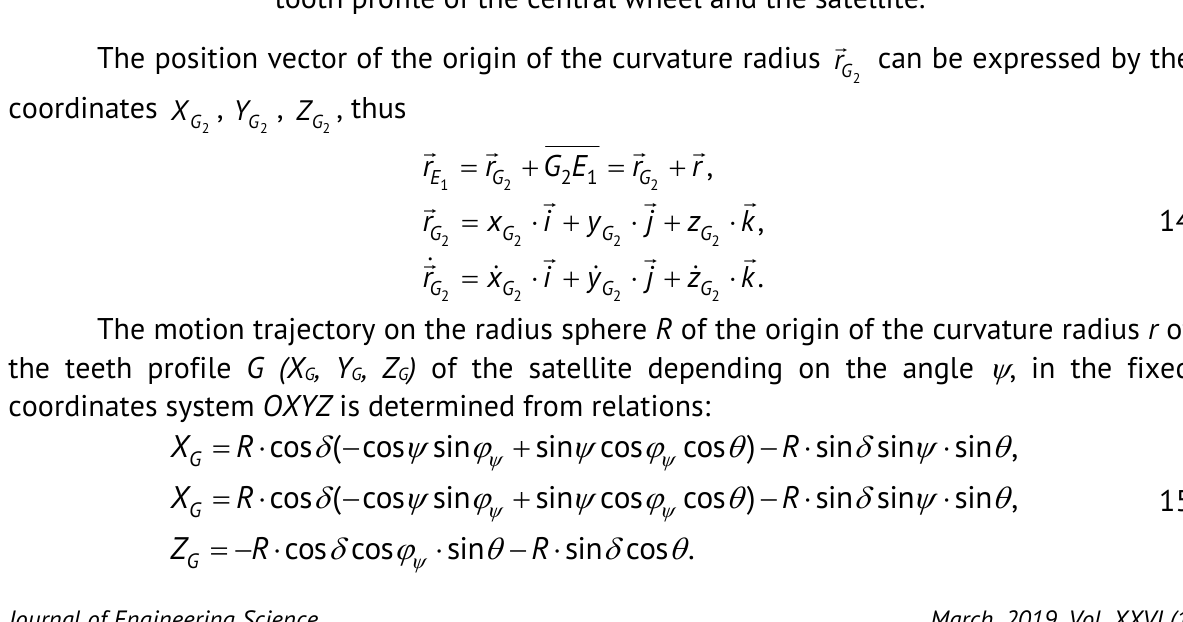
Figure 6. Vector diagram of vector positioning of contact point speeds tooth profile of the central wheel and the